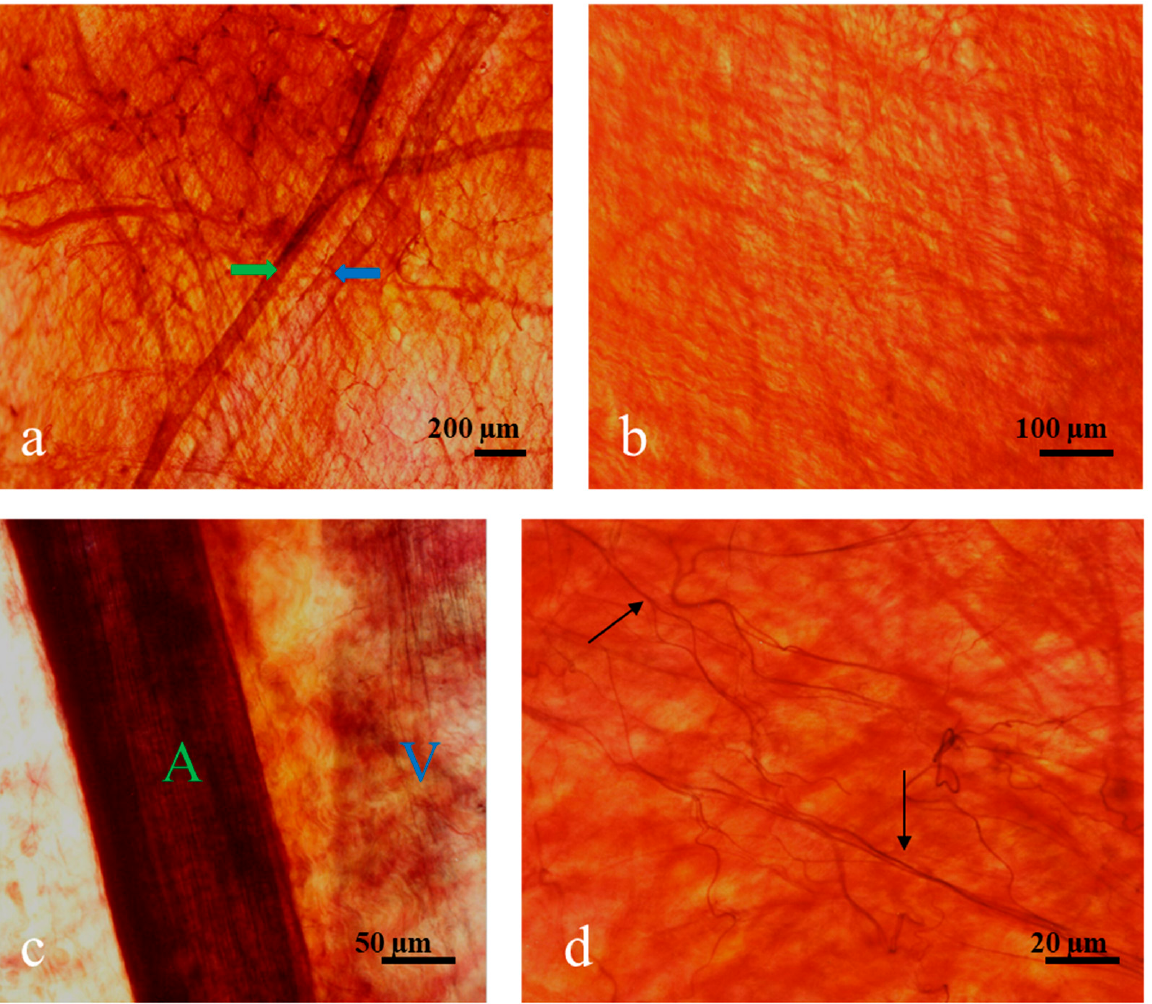
Figure 1. Histochemistry results of connective tissue from natural casings stained with Verhoff‘s Van Gieson stain. Elastin fibers are stained black, and collagen fibers are orange. The photos taken at different magnifications are named a, b, c, and d, respectively. Arteries, and A; veins, and V; elastin fibers, . ( a ) Gross view. Blood vessels, arteries ( ), and veins ( ) are embed- ded in the predominant collagen fibers. ( b ) A casing is mainly composed of numerous layers of